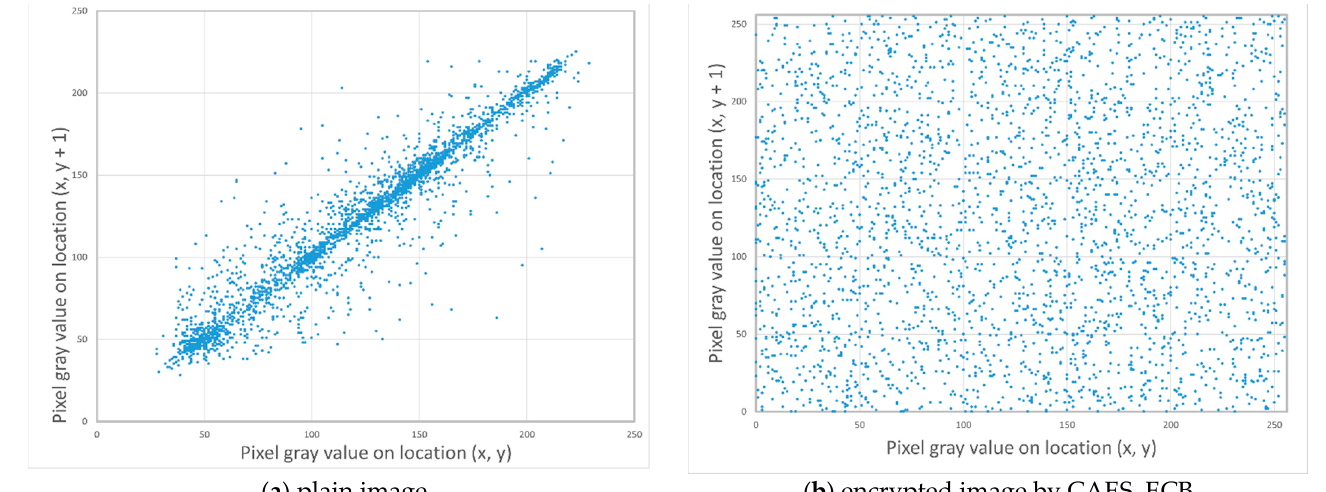
Figure 13. Correlation of the diagonal direction.